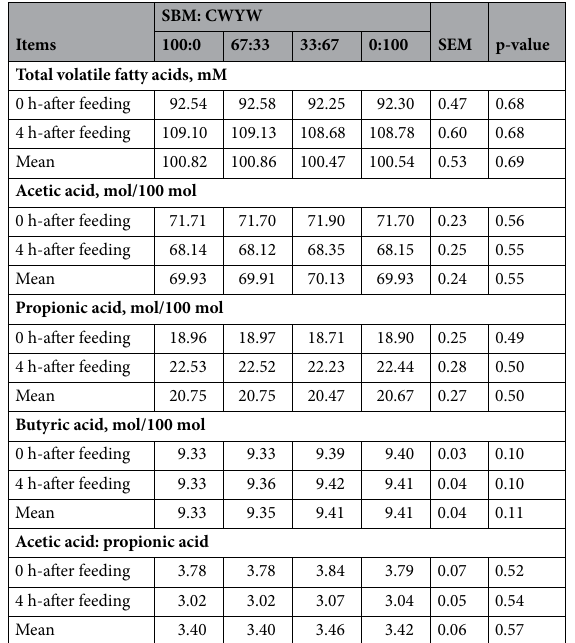
Table 4. Effect of replacing soybean meal with citric waste fermented yeast waste on ruminal volatile fatty acids in Thai-native cattle. SEM standard error of the mean, SBM:CWYW replacing soybean meal with citric waste fermented yeast waste ratio.